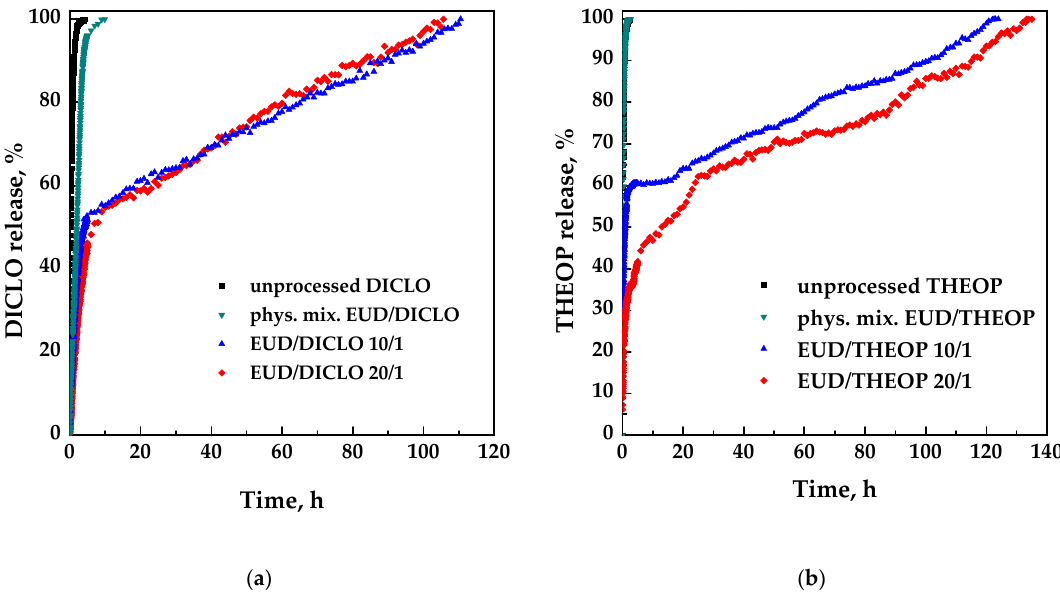
Figure 14. Dissolution profiles in PBS at 37 °C and pH 7.4. ( a ) DICLO; ( b ) THEOP.